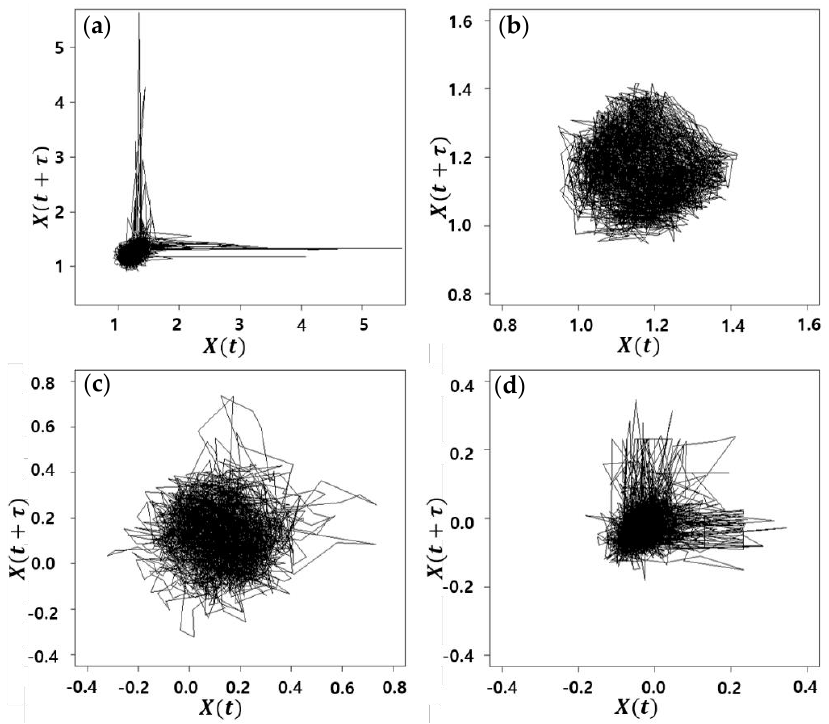
Figure 7. Attractors of each component: ( a ) water level, ( b ) tide component, ( c ) wave component, ( d ) noise component.